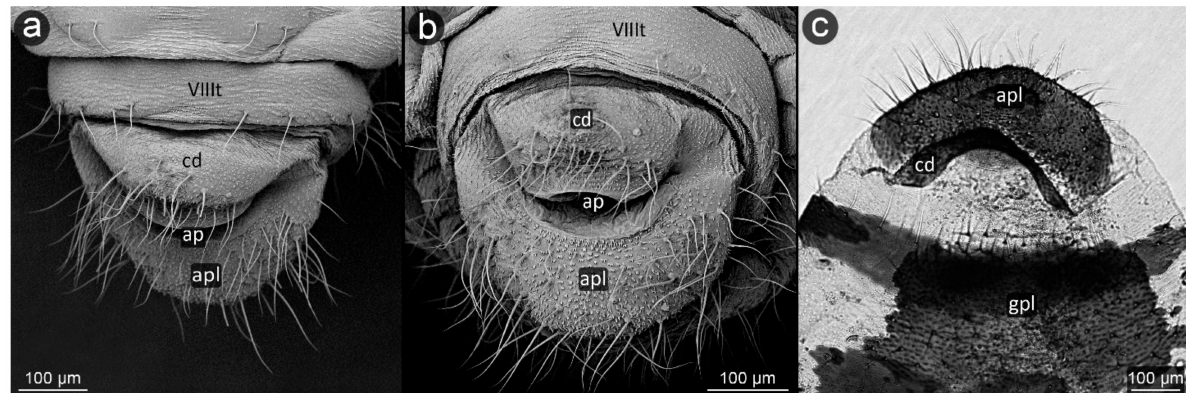
Figure 6. Perianal structure of Symydobius oblongus ; ( a )—dorsal view (SEM), ( b )—rear view (SEM), ( c )— rear view in light